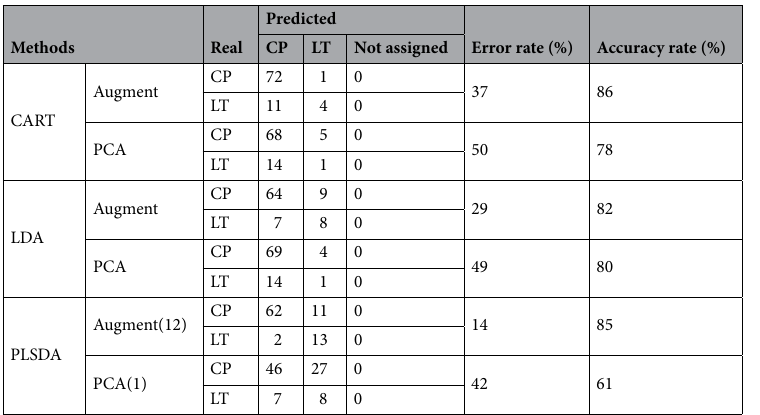
Table 6. The classification performance of CART, LDA and PLSDA on data fused with two different strategies. CP is short for Codonopsis pilosula (Franch.) Nannf ; LT is short for Codonopsis pilosula Nannf. var. modesta (Nannf. ) L. T. Shen; the number in the parenthesis denotes the number of latent variables optimized by eight-fold cross-validation